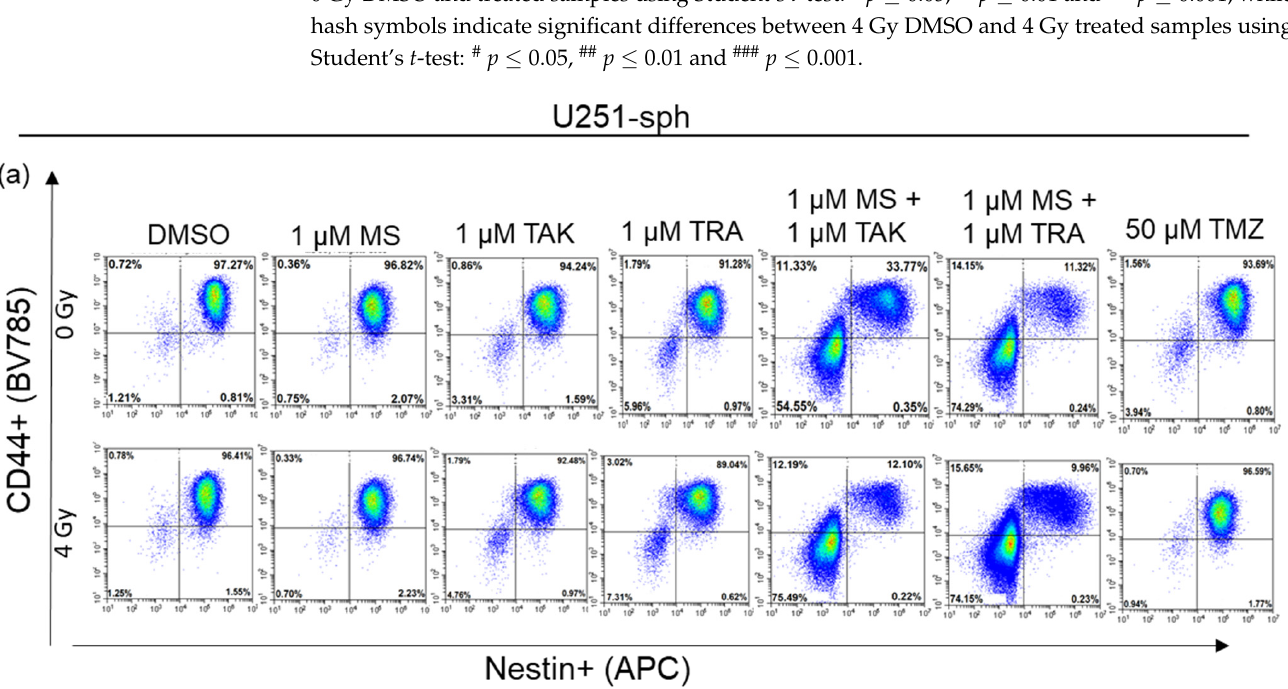
Figure 6. Double expression of GSLC markers reduced by the combination of HDAC and MEK inhibitors with radiation. ( a ) Representative example of flow cytometric plots in U251-sph 72 h after the spheres were treated with HDCAi (1 µM MS-275), MEKi (1 µM TAK-733 or 1µM trametinib), a combination of both (1 µM MS-275 + 1 µM TAK-733 or 1 M MS-275 + 1 µM trametinib) and 50 µM TMZ alone or with 4 Gy radiation. Percentages of double-positive cells for CD44 and Nestin